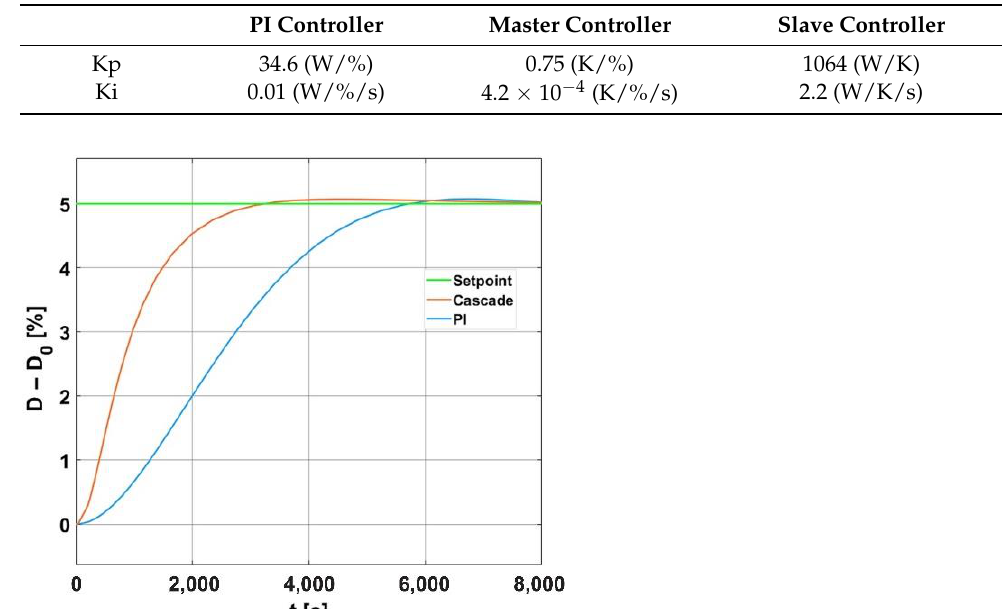
( b ) ( c ) Figure 26. Experimental results of adjusting the dryness of the tape after changing the set value of dryness by 5%. Dryness waveforms ( a ), heating power waveforms ( b ), and cylinder surface temper- ature waveforms during cascade control ( c ). As can be noticed by comparing Figure 26a with Figure 25, the courses of the control action and the final control quality obtained in the experiments were very similar to the